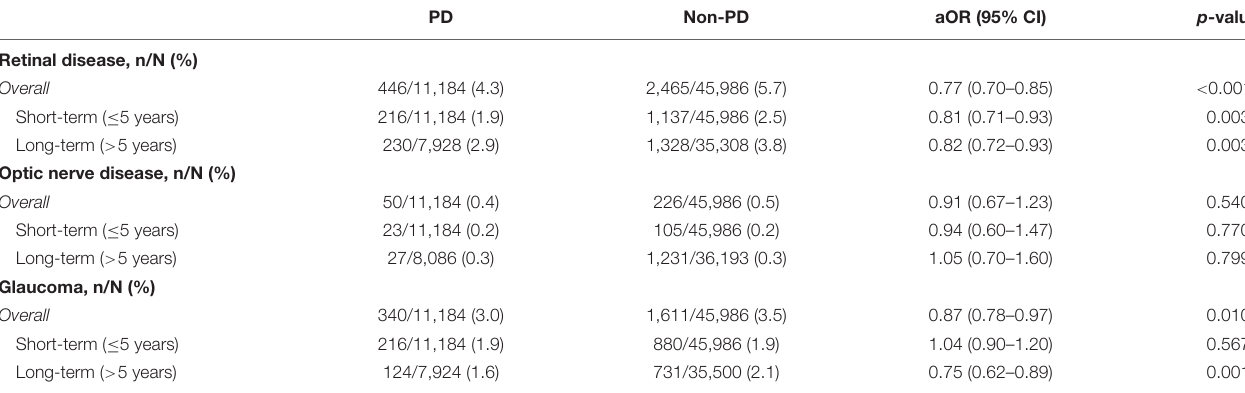
TABLE 3 | The aSHR of retinal disease, optic nerve disease and glaucoma among participants in the cohort study. PD Non-PD aOR (95% CI) p